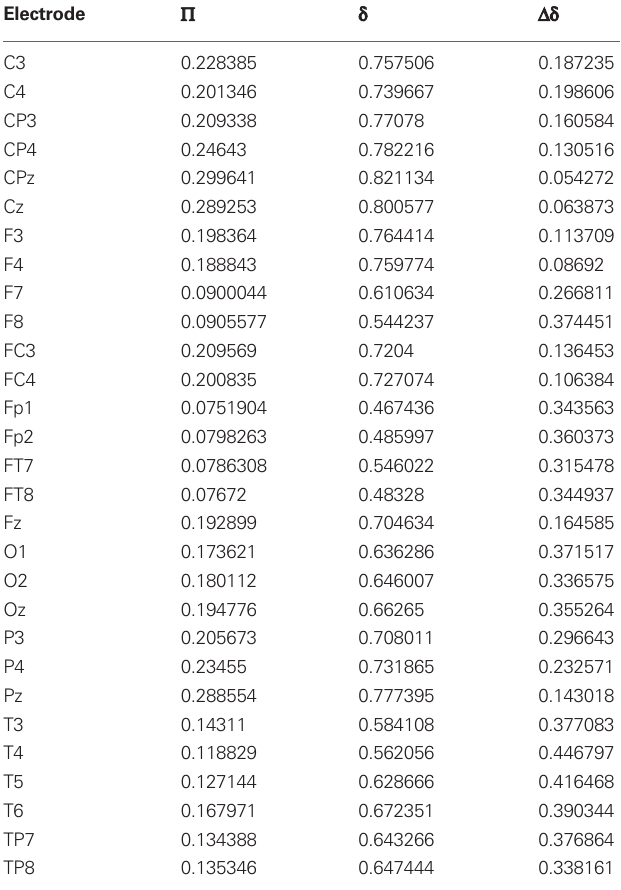
Table 1 | Electrode name, global probability for the channel to be recruited in an avalanche Π (with N = 2), average values of single-electrode δ , and variability ∆δ , defined as the difference between the 75th and the 25th percentile among